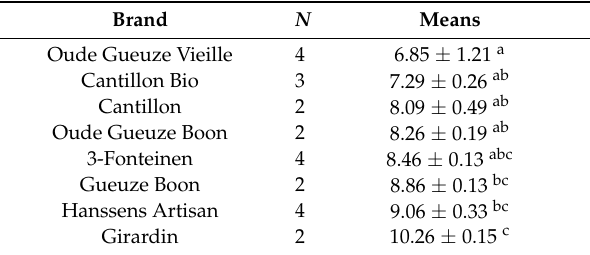
Table 2. Color comparison for commercial lambic (gueuze) beers.